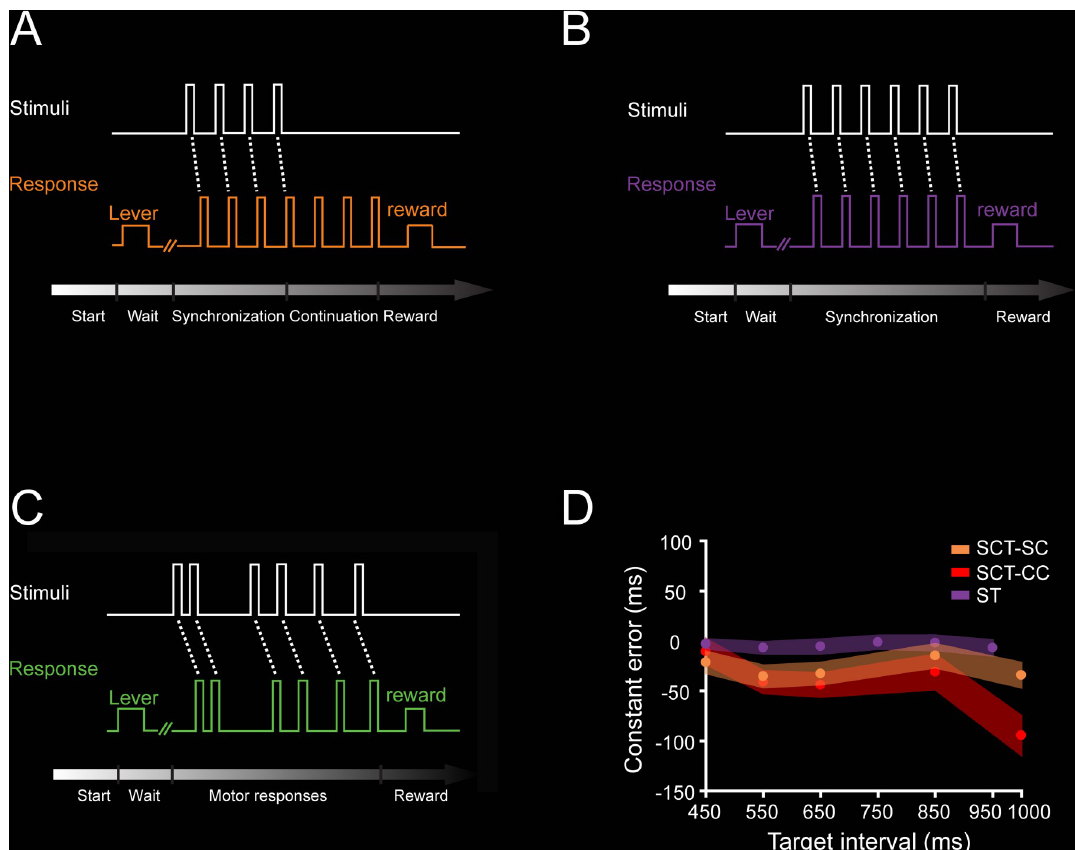
Fig 1. Tasks. A . SCT. The trial started when the monkey placed his hand on a lever for a variable delay. Then, a visual metronome was presented, and the monkey tapped on a button to produce three intervals of a specific duration following the isochronous stimuli (synchronization phase), after which the animal had to maintain the tapping rate to produce three additional intervals without the metronome (continuation phase). Correct trials were rewarded with an amount of juice that was proportional to the trial length. The instructed target intervals were 450, 550, 650, 850, and 1,000 ms. B . ST. Similar to the synchronization phase of the SCT, the animal had to produce five intervals guided by a visual metronome. The instructed intervals were 450, 550, 650, 750, 850, and 950 ms. C . SRTT. As in ST, the trial started when the monkey placed its hand on a lever for a variable delay. However, in this task, the monkey tapped the button after six stimuli separated by a random interstimulus interval, precluding the temporalization of the tapping behavior. D. Constant error (mean ± SD/2) as a function of target interval during the SC (orange) and CC (red) of the SCT (ANOVA main effect interval, F(4, 1,112) = 61.01, p < 0.0001; main effect task condition, F(1, 1,112) = 43.16, p < 0.0001; interval × condition interaction, F(4, 1,112) = 17.66, p < 0.0001), and the ST (purple) as a function of target interval (ANOVA for 450, 550, 650, and 850 target intervals between SC of the SCT and the ST, main effect interval, F(3, 631) = 4.18, p < 0.01; main effect condition, F(1, 631) = 202.16, p < 0.0001; nonsignificant interval × condition interaction, F(3, 631) = 2.46, p = 0.06). Underlying data are available in https:// doid.gin.g-node.org/d315b3db0cee15869b3d9ed164f88cfa/. CC, continuation condition; SC, synchronization condition; SCT, synchronization-continuation task; SRTT, serial reaction time task; ST, synchronization task. metronome, while in the CC of SCT, this was done to an internal representation of the same rhythm. The asynchronies in the SC of SCT were (mean ± SD: 288.7 ± 70 ms). On the other hand, the SRTT involved similar stimuli, tapping behavior, and sequential structure, but no predictive rhythmic timing was possible. Expectedly, the reaction times were significantly larger in the SRTT than the asynchronies in the ST (mean ± SD: 263 ± 37 ms in the ST and 381 ± 46 ms in the SRTT; ANOVA main effect of task: F(1, 718) = 1443.93, p < 0.0001). The constant error, a measure of timing accuracy that corresponds to the difference between the produced and the instructed interval, was slightly negative during SCT and ST, indicating that the monkeys were able to properly produce the intervals with a small underestimation across